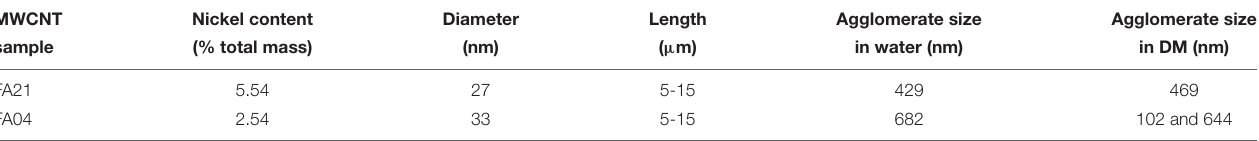
TABLE 1 | Physical characteristics of MWCNT used in this